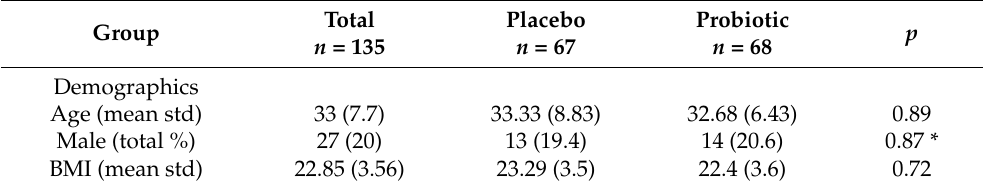
Table 1. Baseline measurements.